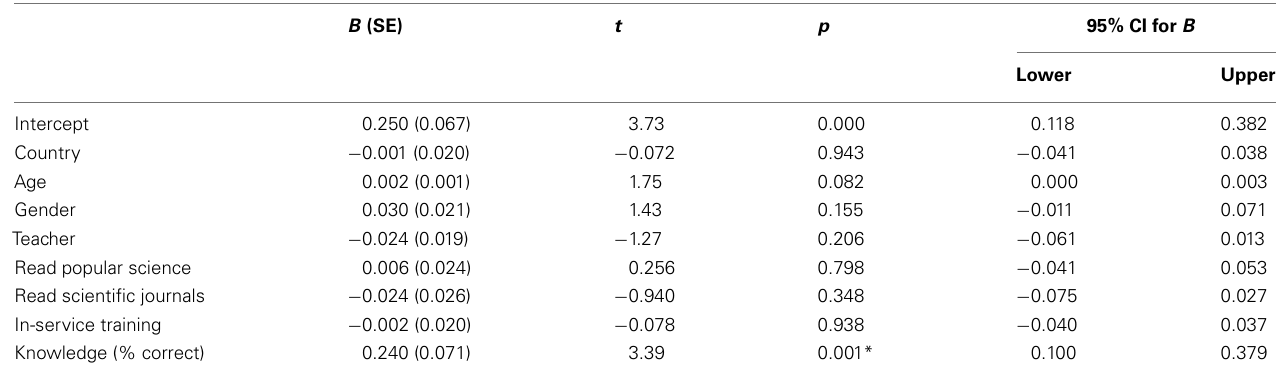
Table 3 | Predictors of neuromyths.